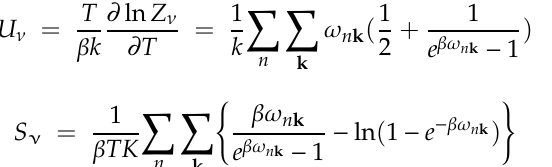
Supplementary Materials: The following are available online, Figure S1: The crystal structure of ice IX., Figure S2: Comparison of calculated and observed lattice constants of ice IX as a function of pressure, Figure S3: The Raman bands of ice phase IX in the low frequency region under di ff erent pressures, Figure S4: The pressure dependence of the Raman bands of ice IX in the high frequency region as a function of pressure, Figure S5: The unit cell of ice XIII, Figure S6: Comparison of the calculated and observed lattice constants of ice XIII, Figure S7: The Raman bands of ice XIII in the low frequency region under di ff erent pressures, Figure S8: The Raman bands of ice phase XIII in high frequency region under di ff erent pressures, Figure S9: The calculated IR spectrum of ice phase XIII under ambient pressure, Table S1: Average computational time of EE-GMF at the MP2 / aug-cc-pVDZ